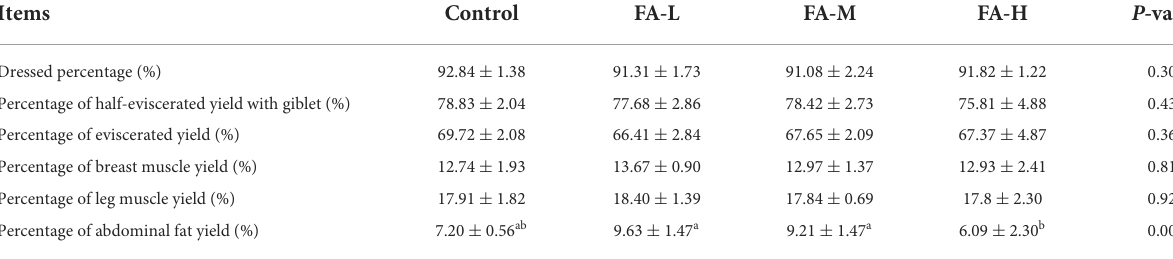
TABLE 3 Effects of dietary supplementation of FA on slaughter performance of Xianju yellow chickens (Mean ± SD). Items